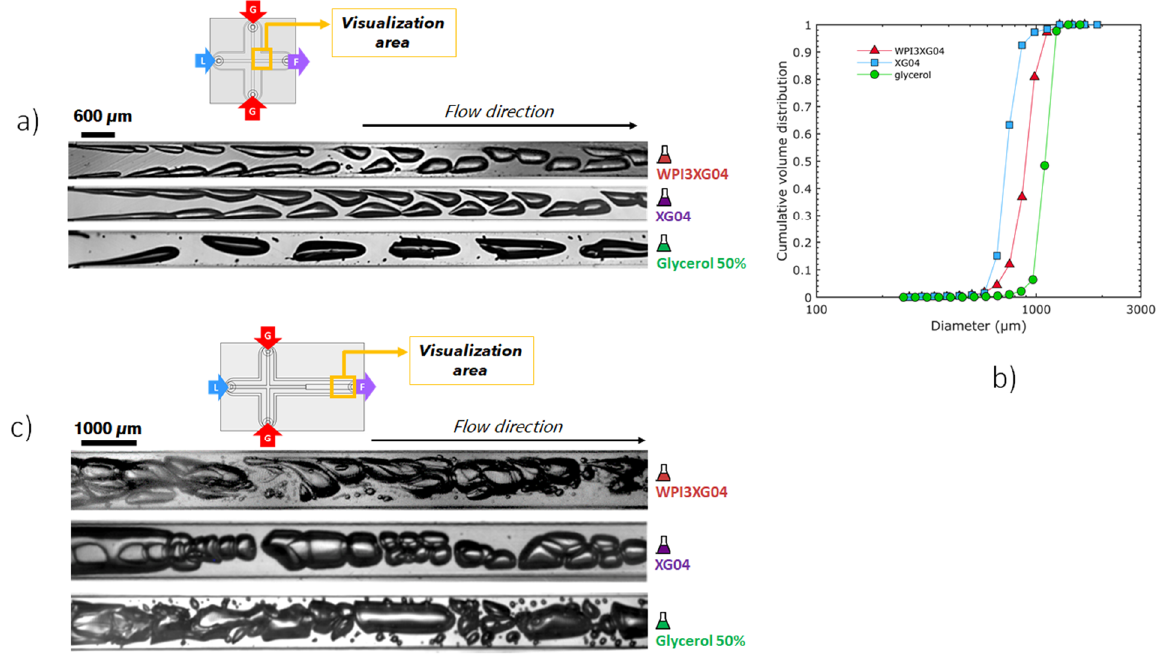
Figure 11. Effect of formulation on two-phase flow typology and bubbles sizes. ( a ) High-speed visualizations of the two- phase flow inside the mixing channel of the device CX600 for solutions WPI3XG04, XG04 and glycerol at Q vL = 11 L.h −1 and Q mG = 21.6 g.h −1 . ( b ) Bubble size distribution in cumulative volume for bubbles inside the mixing channel of CX600 for solutions WPI3XG04, XG04 and glycerol at Q vL = 11 L.h −1 and Q mG = 21.6 g.h −1 . The diameters of bubbles inside the micro- channels are normalized to the atmospheric pressure. ( c ) High-speed visualizations of the two-phase flow inside the ex- pansion channel of the device CX-E-600 for solutions WPI3XG04, XG04 and glycerol at Q vL = 3 L.h −1 and Q mG = 5 g.h −1 . Table 4. Hydrodynamic parameters of the two-phase flow in the mixing channel of the microfluidic device CX600 for the XG04, WPI3XG04 and glycerol solutions at Q vL = 11 L.h −1 -Q mG = 21.6 g.h −1 . Solution 2.25 Figure 12. Visualizations of bubbles in the outlet microchannel and visual aspect of foams ob- tained at the end of the process when using the device CX600 and flowrates Q vL = 11 L.h −1 and Q mG